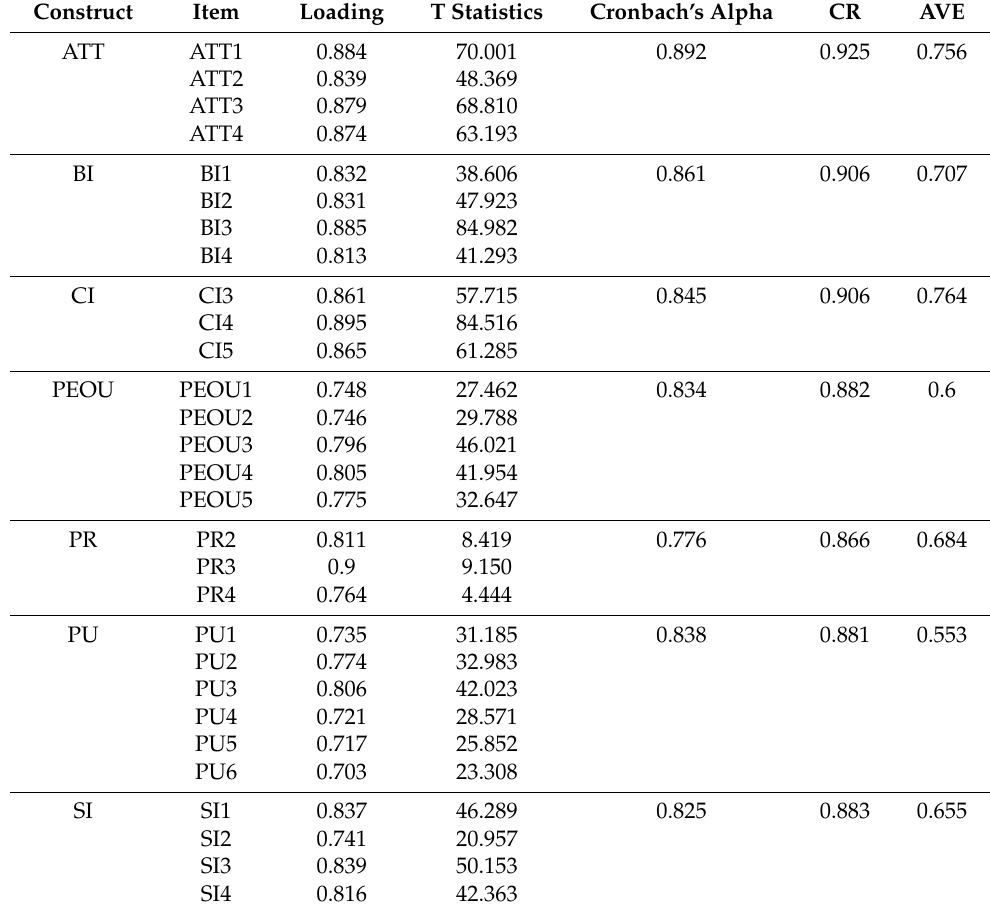
Table 4. Reliability and convergent